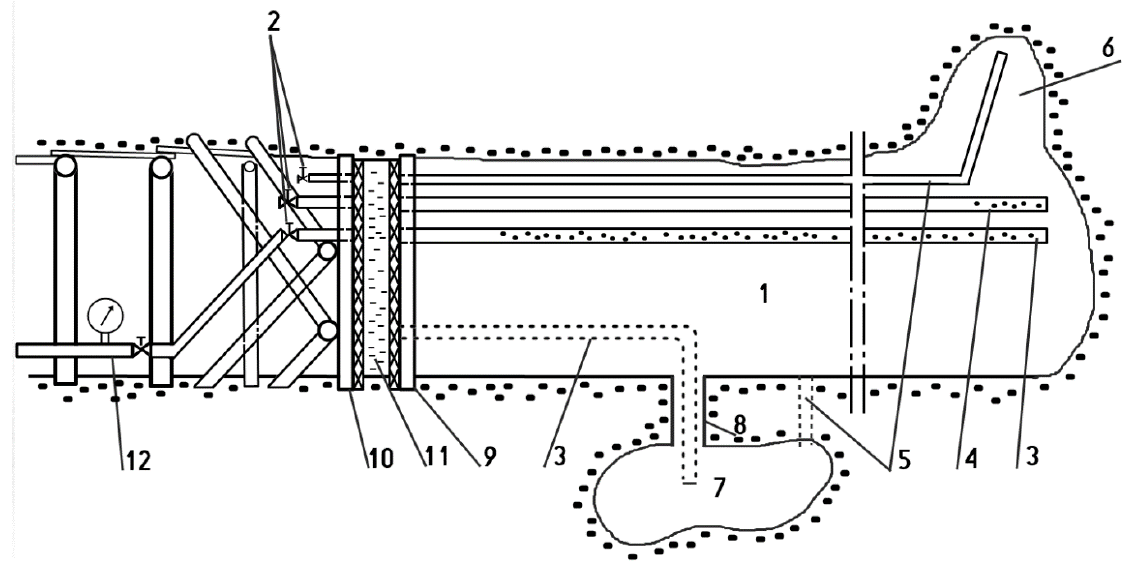
Figure 4. Diagram of a mining excavation showing the longitudinal section with an installation for